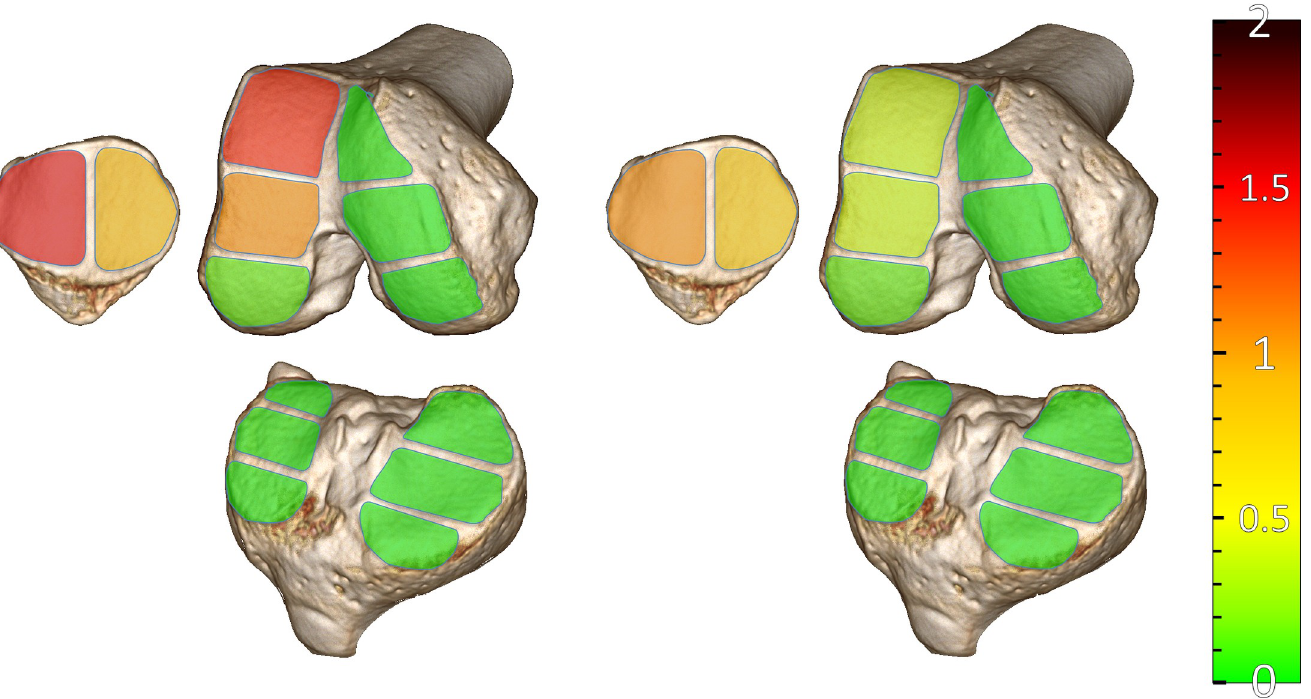
Fig 1. Average cartilage damage of the various subregions in male (left) and female (right) patients according to WORMS.